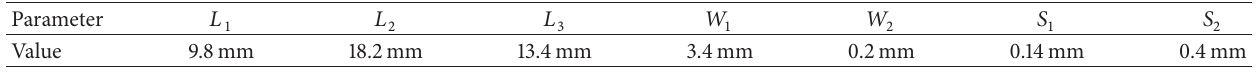
Table 2: Optimized values for the broadband band-pass filter given in Figure